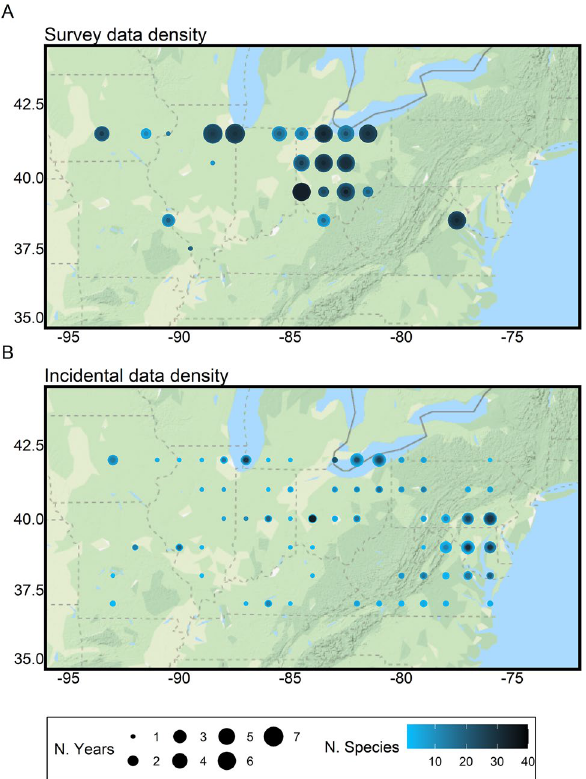
Figure 1. Study region with phenometric density from standardized surveys from the US butterfly monitoring network ( A ) and incidental data from iNaturalist and eButterfly ( B ). Phenometric density is described by concentric circles at one-degree grid cell centroids, where the diameter of the circle is number of years (1–7) and the color shade is the number of species with phenometrics for that number of years. The color of the inner-most ring of each circle represents the number of species with phenometrics in at least one year. Each successive ring outwards shows how many species had phenometrics in 2–7 years respectively. ( A ) demonstrates that butterfly survey phenometrics are currently limited geographically, but are taxonomically rich, while ( B ) shows that the incidental phenometrics are widespread but sufficient data were available for fewer species in many grid cells. This figure was made with the ggplot and ggmap packages in R 77